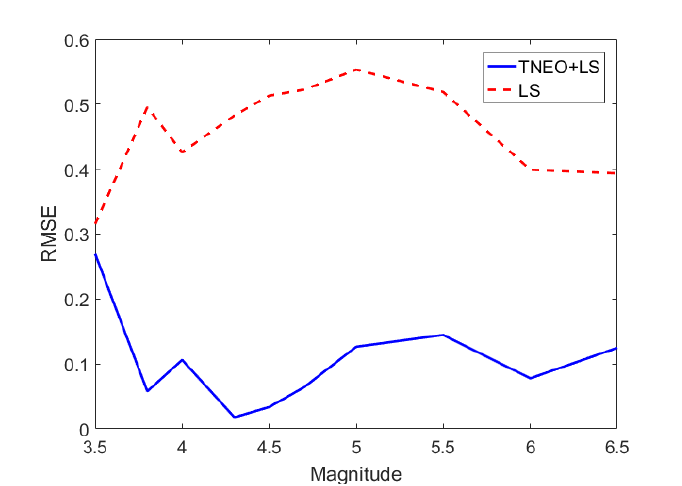
Figure 6. RMSE change for earthquake